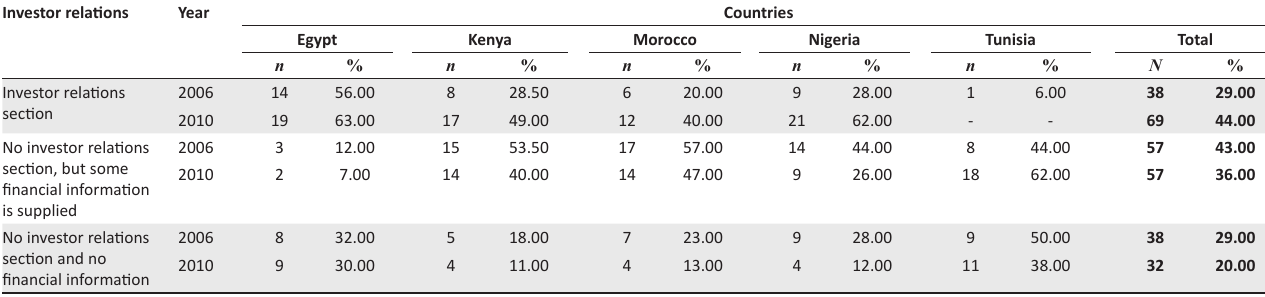
TABLE 2: Provision for investor relations on existing working corporate